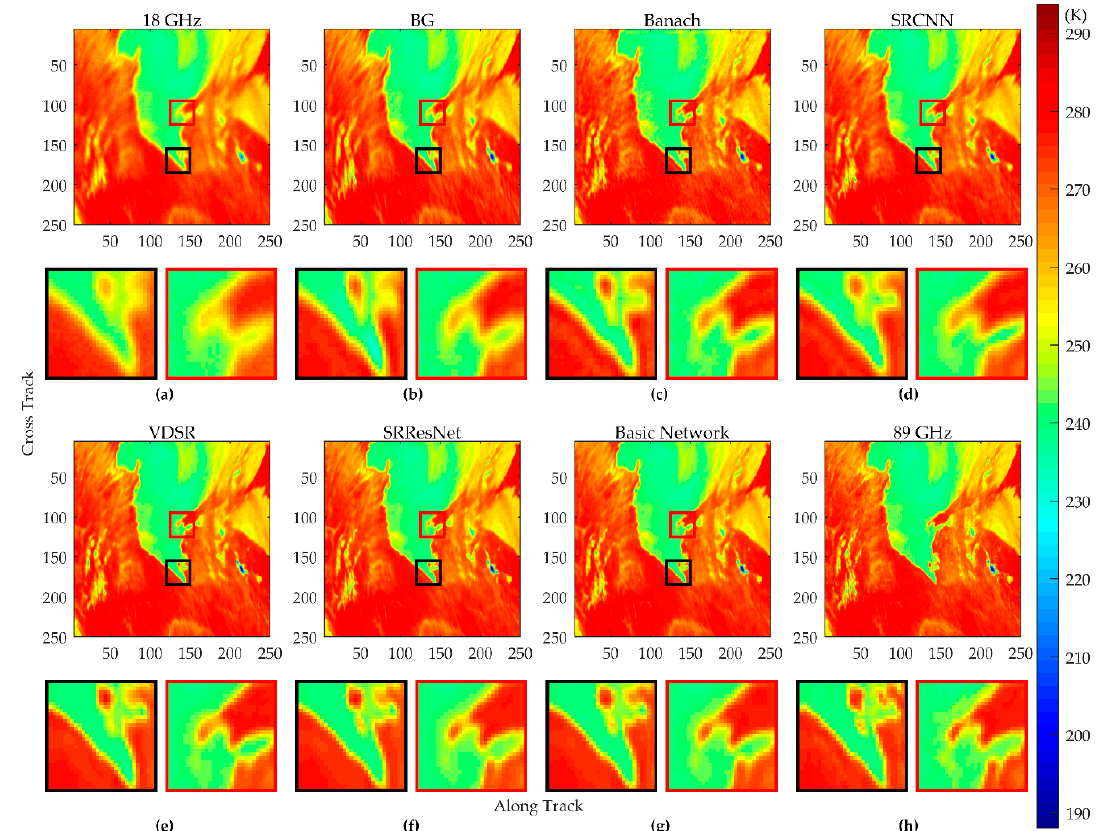
Figure 10. A pair of test set images and their resolution match results. (a) Simulated 18.7 GHz antenna temperature image; (b) Match result of the BG method; (c) Match result of the Banach method; (d) Match result of SRCNN; (e) Match result of VDSR; (f) Match result of SRResNet; (g) Match result of basic network N b ; (h) Simulated 89 GHz antenna temperature image.